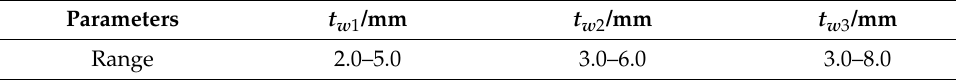
Table 4. Ranges of variables for size optimization.